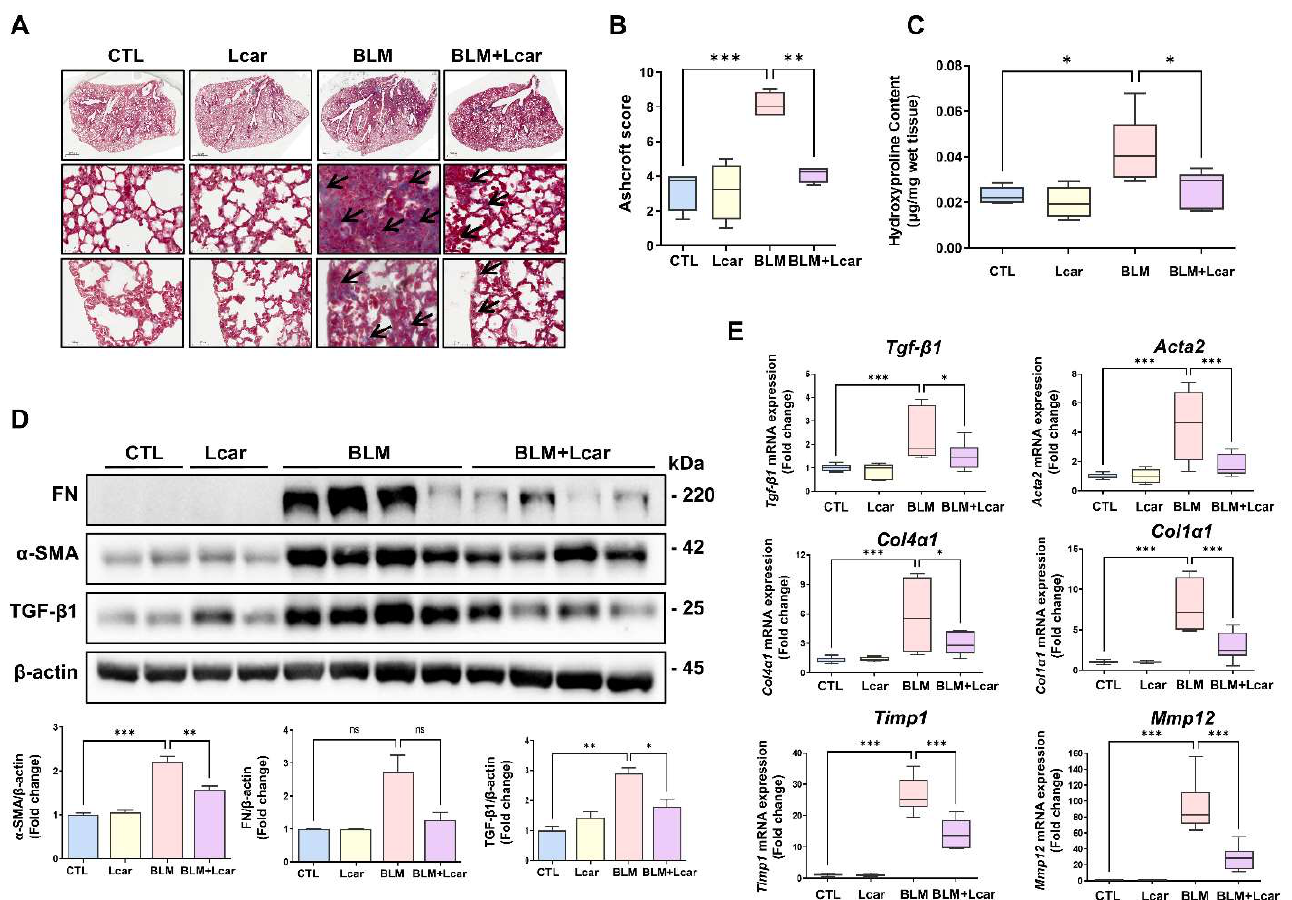
Figure 2. L-carnosine downregulated collagen deposition in bleomycin-induced fibrosis. It was pictured various regions including whole lung ( top ), proximal ( middle ), and distal ( bottom ). ( A ) The lung tissue was stained using M/T staining. Pathological lesions were indicated with black arrows ( B ) Ashcroft score of each group. ( C ) Hydroxyproline contents in tissue of each group ( n = 4/group). ( D ) Protein expression of Fibronectin, α-SMA, and TGF-β was measured by Western blot and relative density ratio. ( E ) mRNA expression of fibrosis-related genes was measured by real-time PCR ( n = 4/group). A value of * p < 0.05, ** p < 0.01, and *** p < 0.001 was compared with each indicated group by one-way ANOVA. CTL, Control; L-car, L-carnosine; BLM, Bleomycin; FN, Fibronectin. Scale bar: 1000 μm ( top ) or 50 μm ( middle , bottom ).